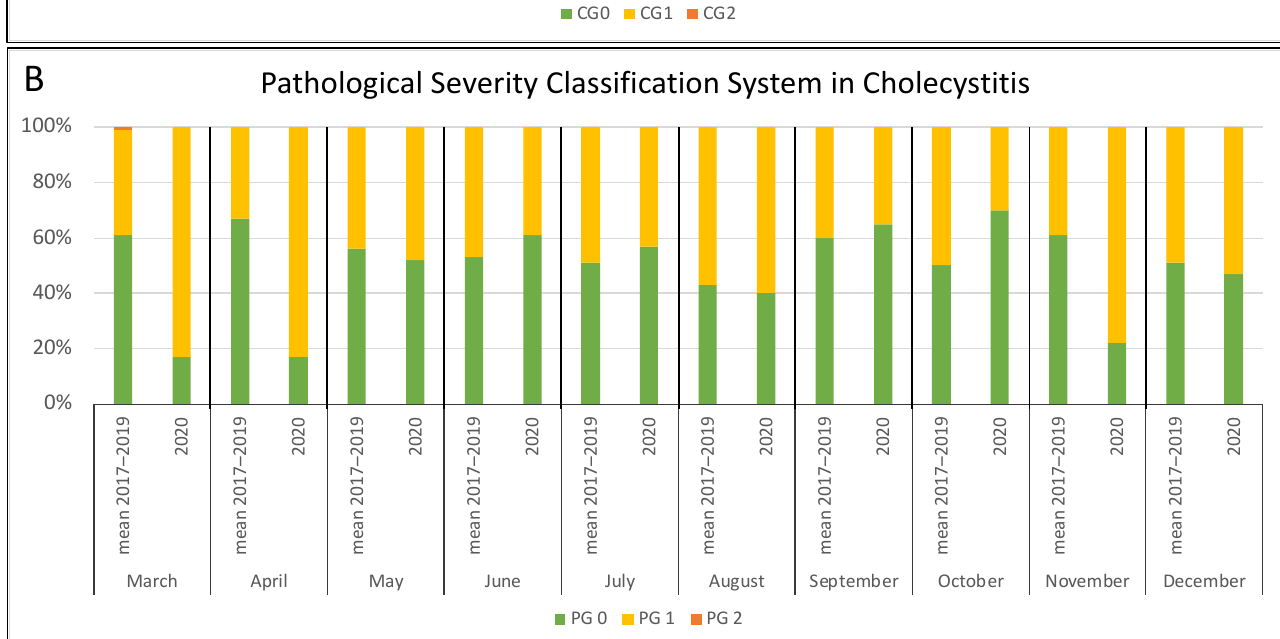
Figure 3. Monthly distribution of patients undergoing surgery for cholecystitis according to the clinical ( A ) and pathological ( B ) severity classification system: comparison between the 2017–2019 period and 2020.